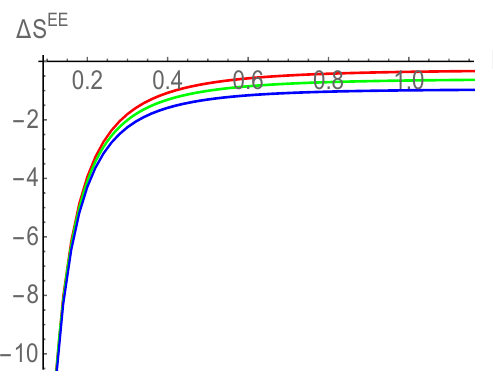
Figure 36 . (cid:1) S EE = S EE (cid:0) S EE as a func- con discon tion of ‘ in the dual decon(cid:12)nement phase of the large black hole. Here (cid:22) = 0 and red, green and blue curves correspond to T=T c = 1 : 2, 1 : 6 and 2 : 0 respectively. In units